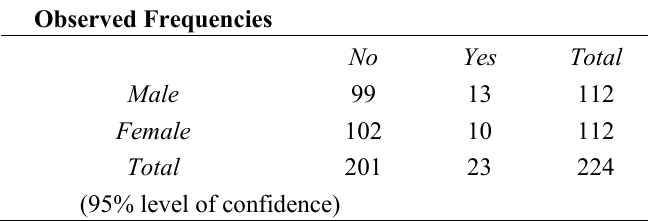
Table 3. Cross tabulation analysis between gender and aggression.